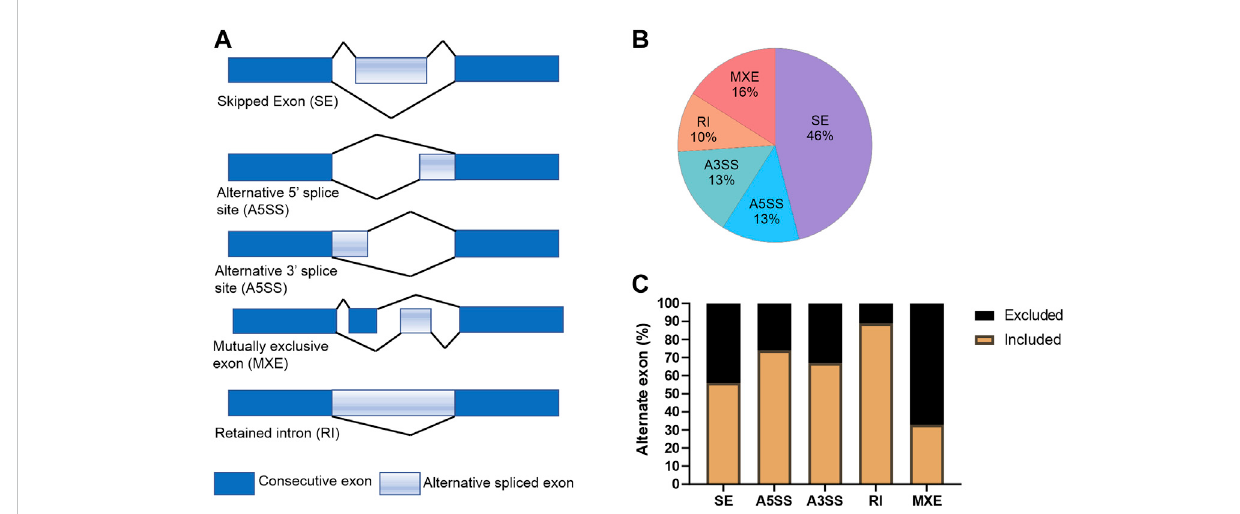
FIGURE 5 Alternative splicingevents in CPI-treated LNCaP cells. (A) Graphical representation ofthealternative splicing events. (B) Percentage ofeach splicing event for the 13088 differential spliced variants between vehicle and CPI-455 treated LNCaP cells. (C) Graph showing the percentage of inclusion and exclusion of the exon cassette/exon upon CPI-455 treatment for each splice